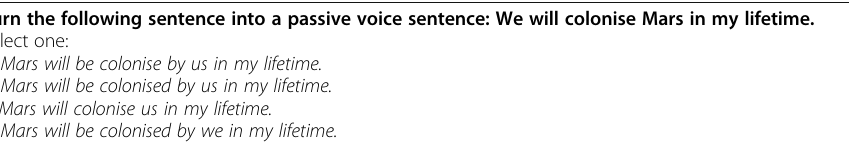
Table 2 A sample question from